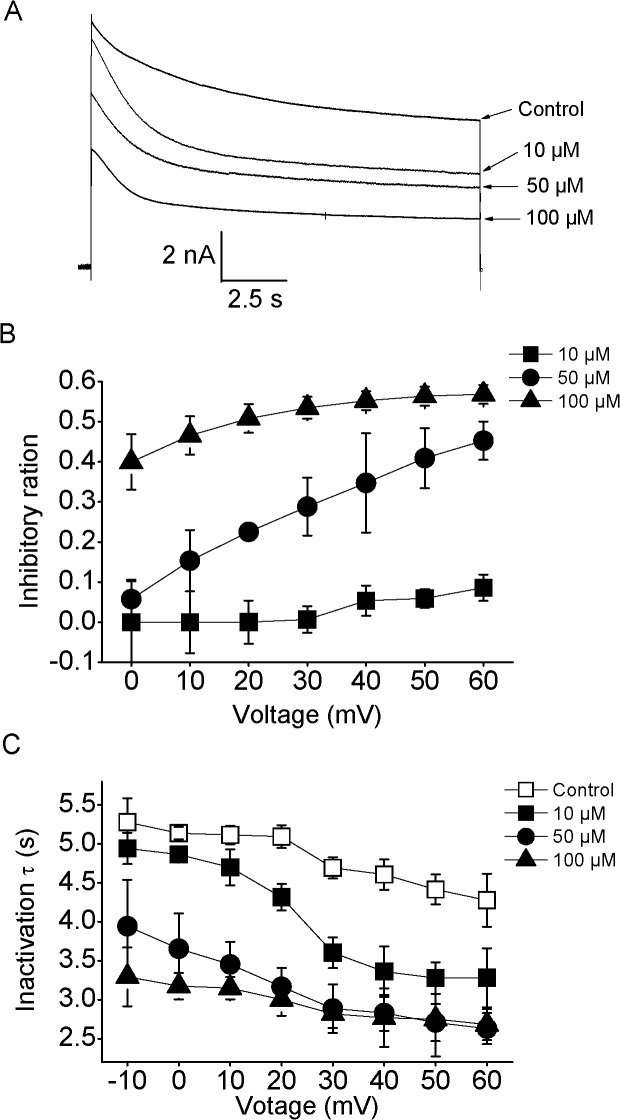
The blockage of Kv2.1 currents by nifedipine in a voltage-dependent manner.(A) The representative current traces were exhibited in the absence and presence of 10, 50 and 100 μM nifedipine. Currents were generated by a 15 s voltage pulse to +60 mV from the holding potential of -80 mV. (B) Different levels of nifedipine inhibited Kv2.1 currents in a voltage-dependent way (n = 8). (C) The voltage-dependent accelerations of inactivation time constants (τinact) were induced by different levels of nifedipine. τinact was determined by fitting the current elicited by protocol described above using single exponential function (n = 9).